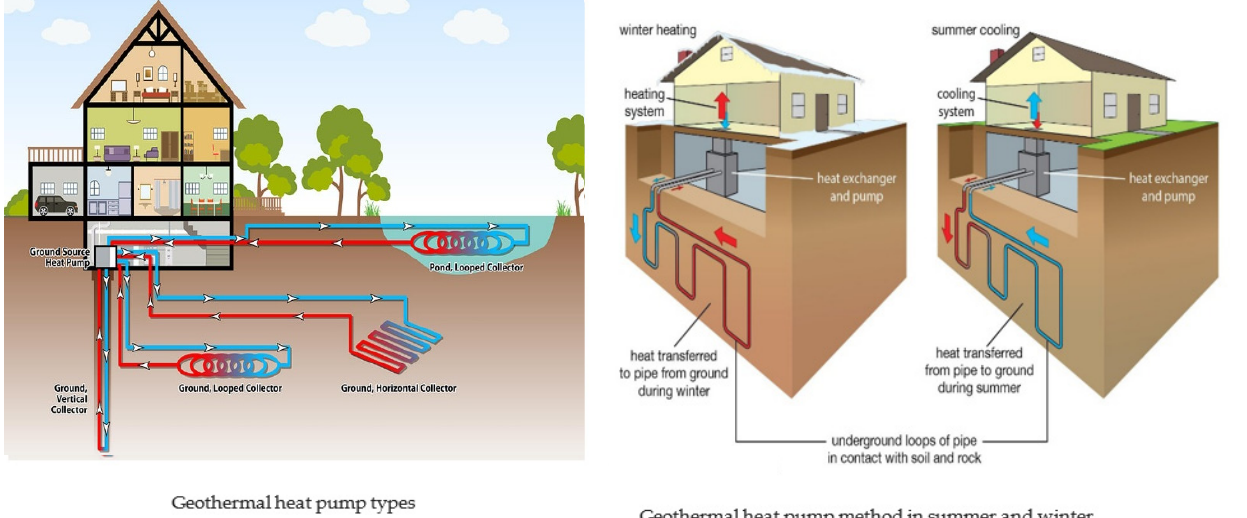
Figure 2. Residential geothermal heat pump types and